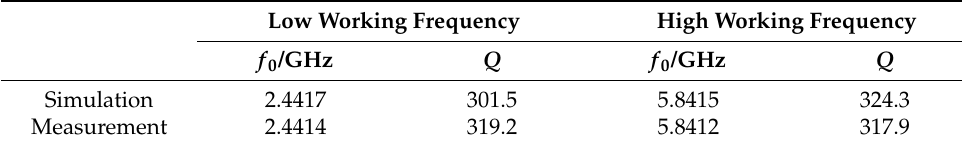
Table 1. Measurement and simulated resonant characteristics.